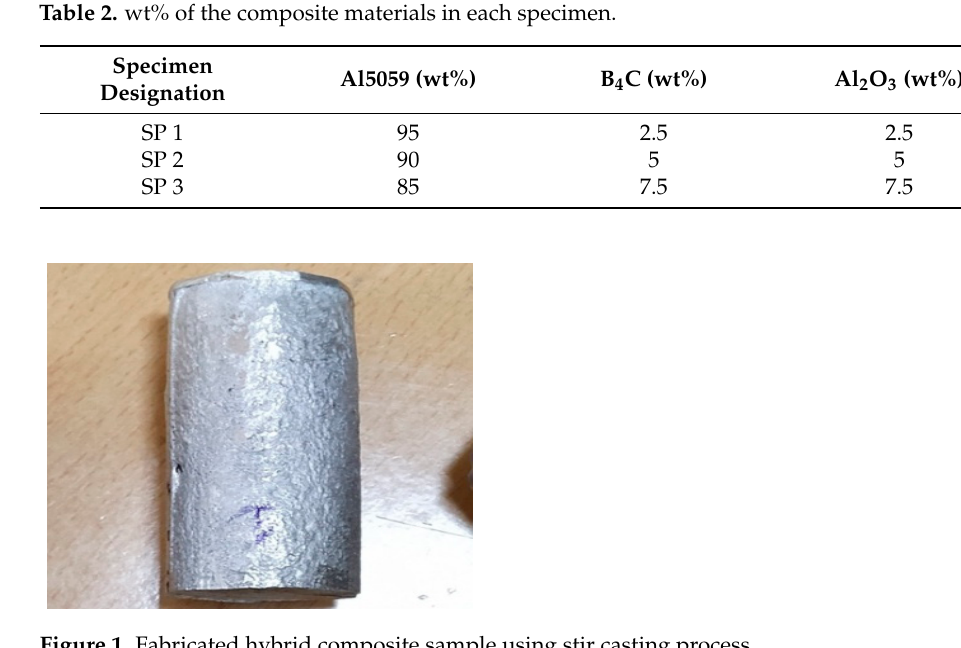
Table 2. wt% of the composite materials in each specimen.